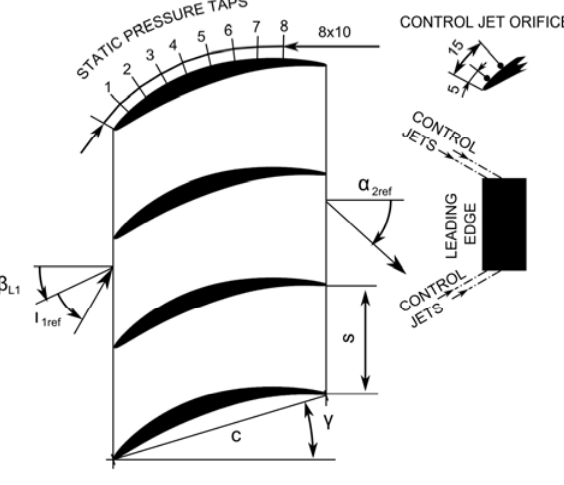
Fig. 2 . Geometry of the investigated blade cascade - lower profiles.